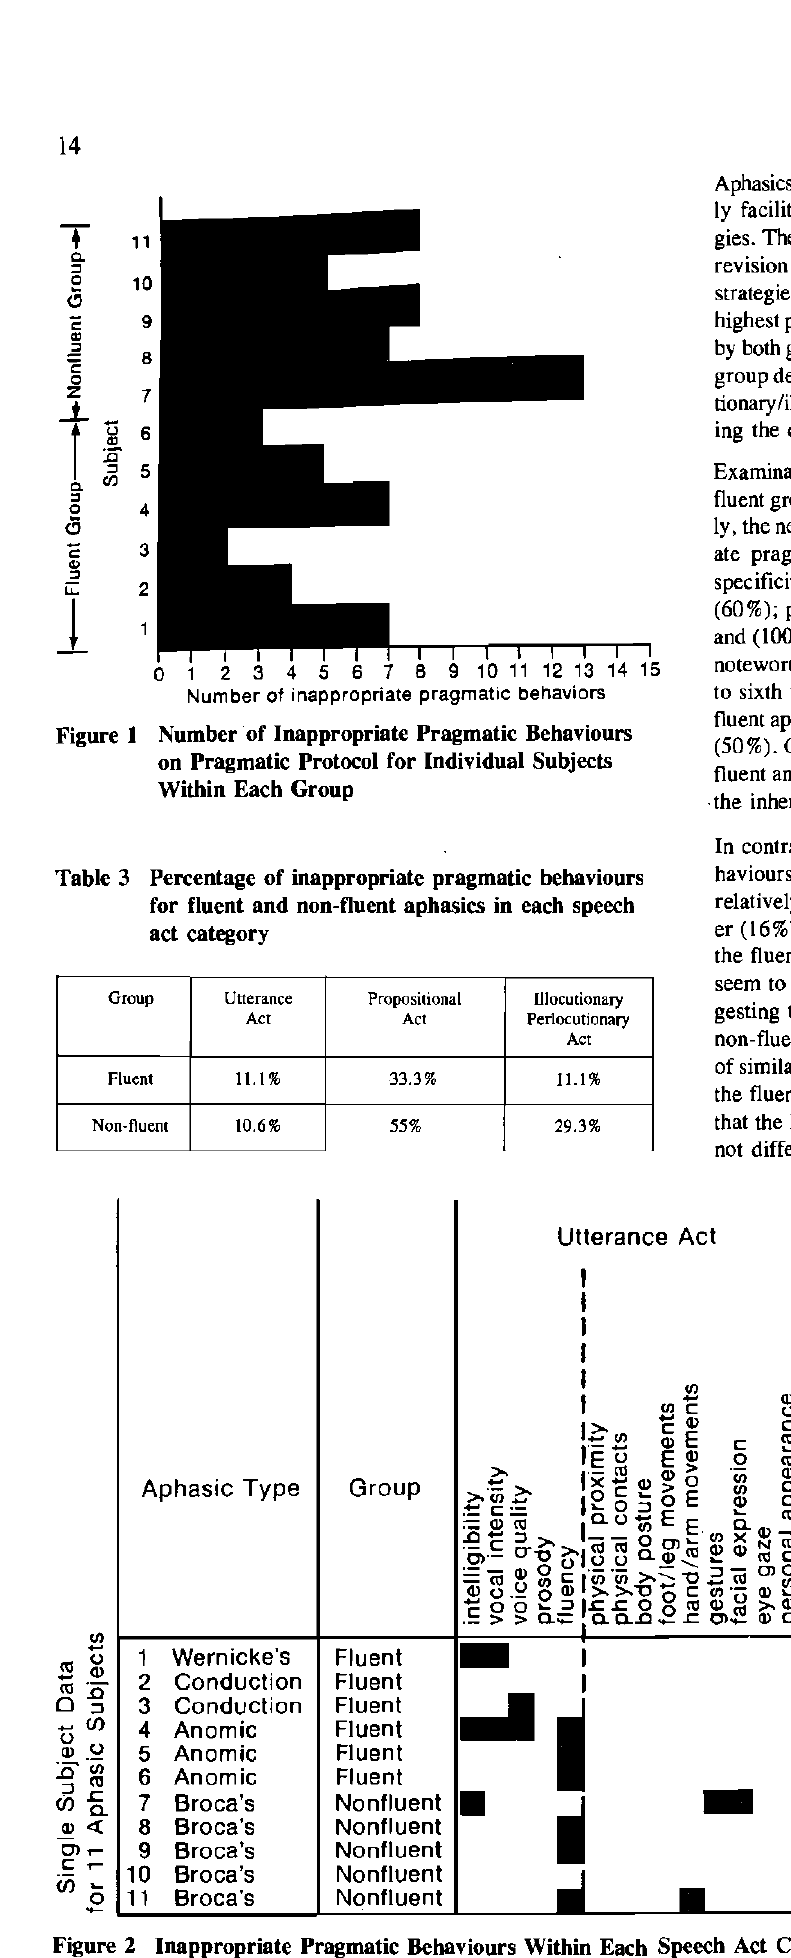
Figure 2 Inappropriate Pragmatic Behaviours Within Each Speech Act Category on Pragmatic Protocol for Individual Subjects in Fluent and Non-fluent